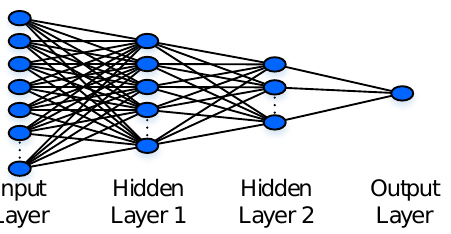
Figure 8. The ANN structure for detecting the RPW infestation using the temporal/spectral